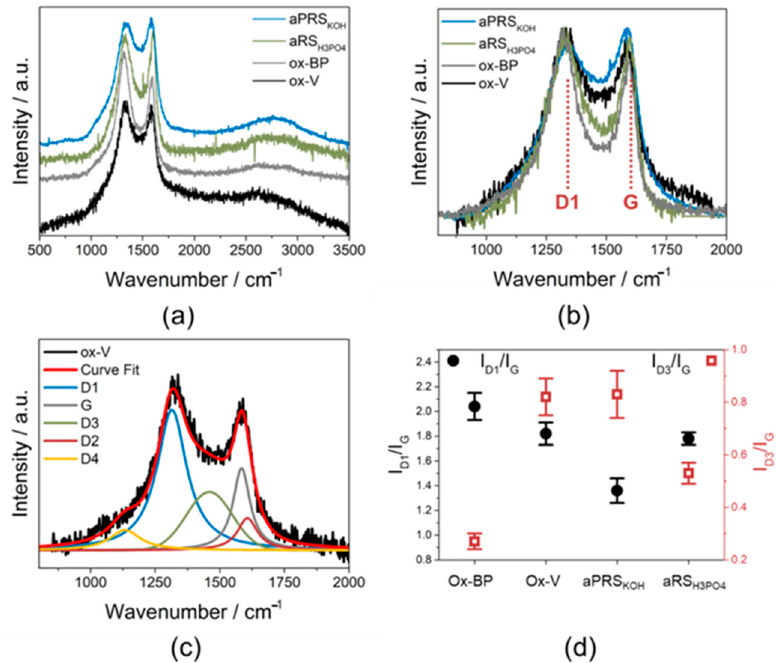
Figure 3. ( a ) Raman spectra of four different carbons; ( b ) first order Raman spectra with indicated D1- and G- band; ( c ) example of curve fitting of Raman spectra according to Sadezky et al. [37]; and ( d ) intensity ratios of D1/D3-band to G-band.